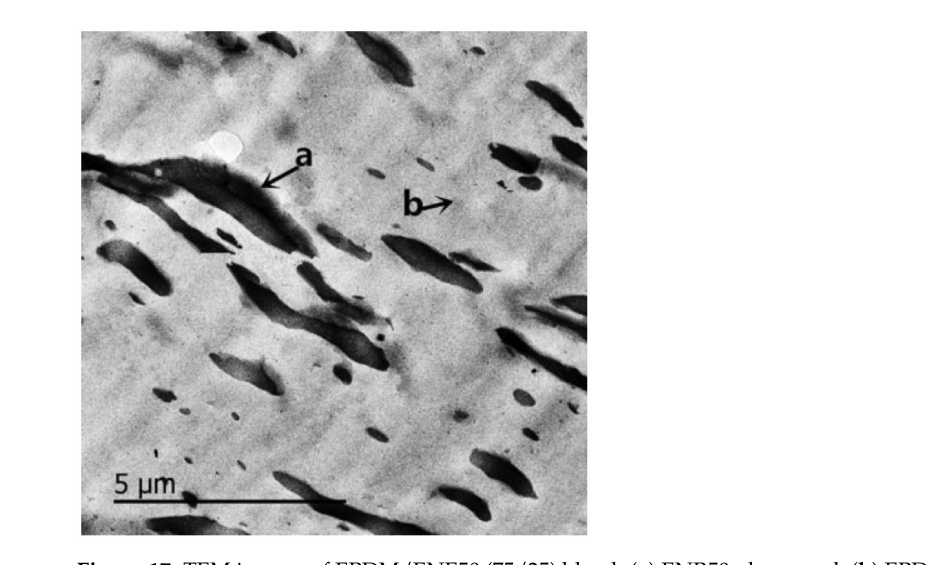
Figure 17. TEM images of EPDM/ENE50 (75/25) blend: ( a ) ENR50 phase, and; ( b ) EPDM phase [55].